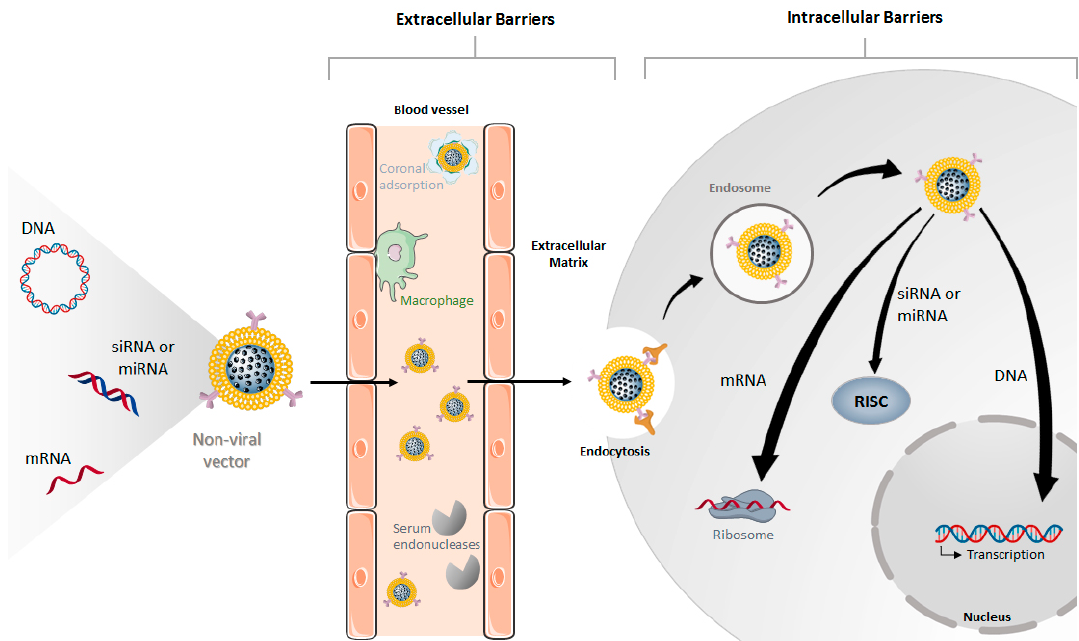
Figure 1. Physiological barriers to systemic delivery of different types of nucleic acids using non-viral vectors. Extracellular barriers include degradation by endonucleases, adsorption of serum proteins, clearance by the renal system or reticuloendothelial system (RES), and extracellular matrix penetration. After targeted cellular uptake, endo/lysosomal escape is also required for successful delivery. Finally, siRNA and miRNA molecules must be loaded into the RNA-induced silencing complex (RISC), while mRNA must be read by the ribosome and DNA ought to enter the nucleus for transcription.